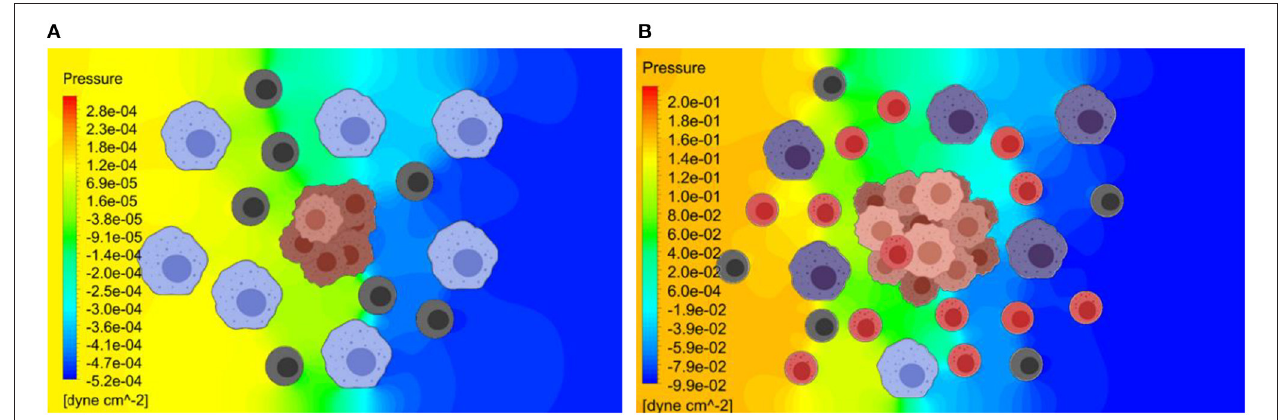
FIGURE 7 | Pressure distribution in the TME at the early and later stages of tumor growth. The Navier-Stokes equations are used to estimate the interstitial fluid flow velocities and the pressure distribution within TME. (A) Predicted pressure distribution at early stage. (B) Predicted pressure distribution at later stage. The predicted pressure distribution is greater for the later stage of the tumor growth, due to greater obstruction for the flow by a larger